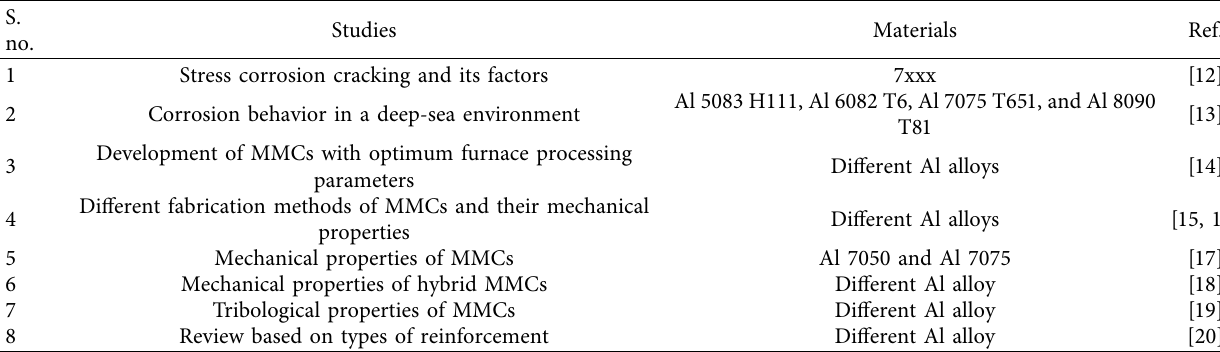
Figure 1: Usage of (a) matrix and (b) reinforcement materials in MMCs Table 1: Previous review articles based on aluminium composites.